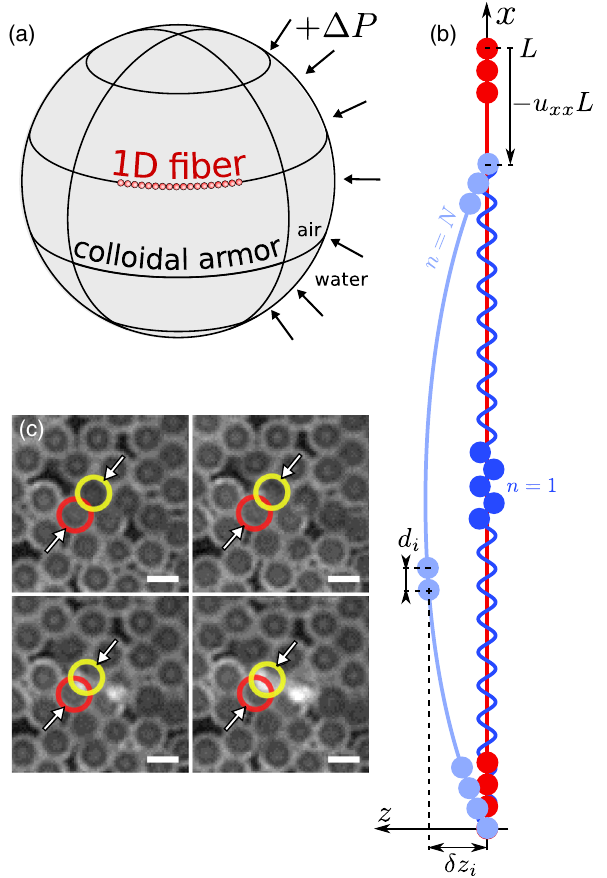
FIG. 4. (a) Sketch of the colloidal armor with an arbitrary 1D fiber highlighted in red. (b) Sketch of the buckling of the fiber. The red line shows the undeformed initial state of the fiber of length L ; the blue lines are the deflected sinusoidal states. Light blue is the lowest frequency mode; dark blue is the highest frequency mode with alternating beads. (c) Detail from fluores- cence micrographs of the buckling event (movie 4 in Ref. [26]), where the beads overlaid in red and yellow overlap and come out of the plane of the monolayer. The direction of the compression is indicated by the white arrows. Scale bars are 5 μ